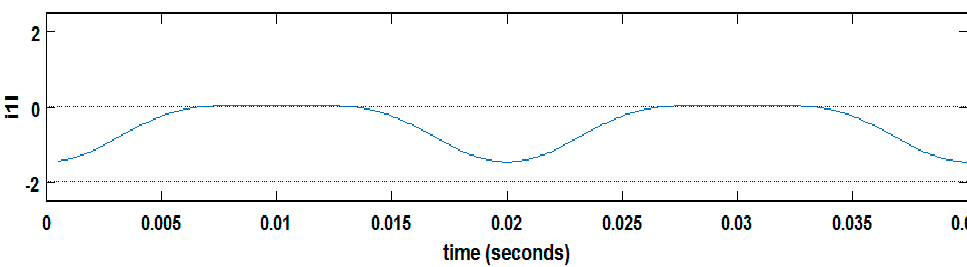
Figure A2. Lower arm current—proposed direct modulation.